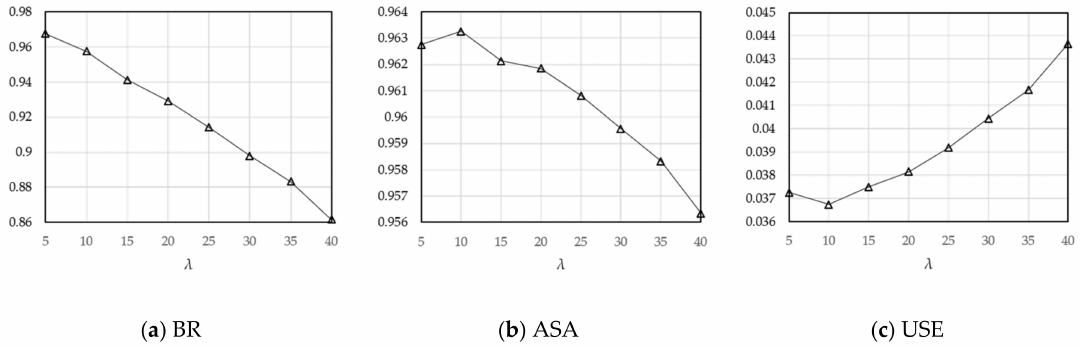
Figure 6. The performance metrics of our approach with di ff erent λ values at k = 400.